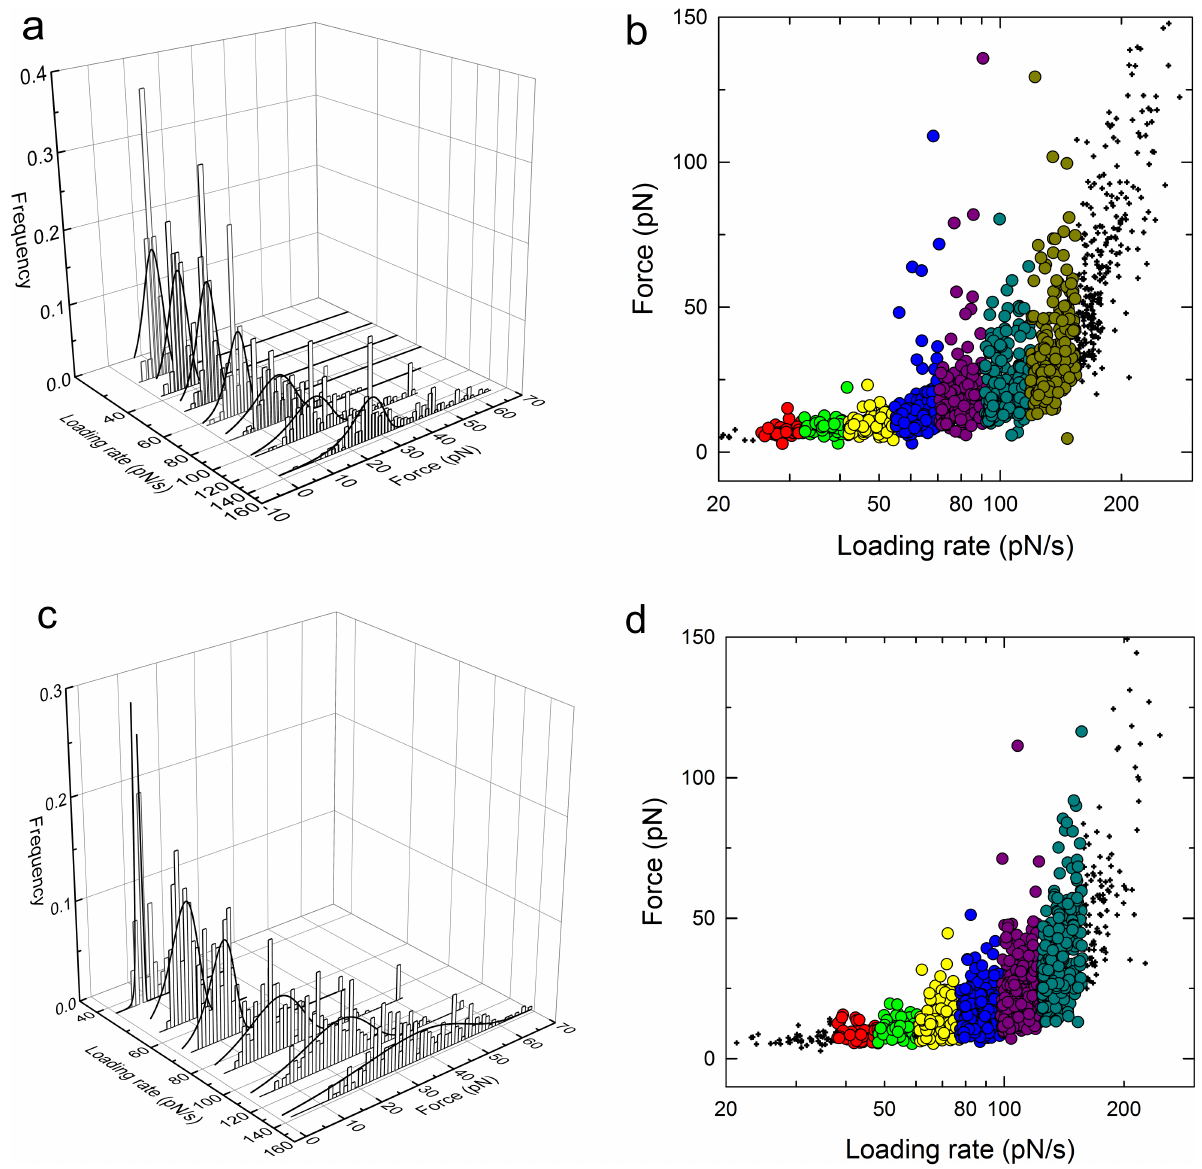
Fig 4. Distributionof experimentally determined MUC1(Tn)—MGL (a and b) and MUC1(STn)—MGL (c and d) rupture forces at increasing force loadingrates. The data are collectedfrom force curves obtainedusing a retraction speeds equal to 1 μ m/s. The loadingrate r f acting at a molecularbond was determinedfor each force jump from the slope Δ f/ Δ t before each observed bond dissociation event. Based on the determinedloadingrate, subgroupswere definedwithin the continuous distribution of observations. (a and c): 3-dimensional plot revealing the histogramdistributionsof experimentally determined rupture forces containedwithin each of the predefinedintervals of loadingrates as a function of increasing force-loading rate. The continuous line depicts the fit of P(f) (Eq 2) to the histograms. (b and d): 2-dimensional plot revealingthe distribution of rupture events as a function of increasing force-loading rate. The color-coding(large symbols) depicts the groups of data for the histogramanalysis, whereasthe smaller symbols depict observations where subgroups where not sufficiently large to apply the histogram